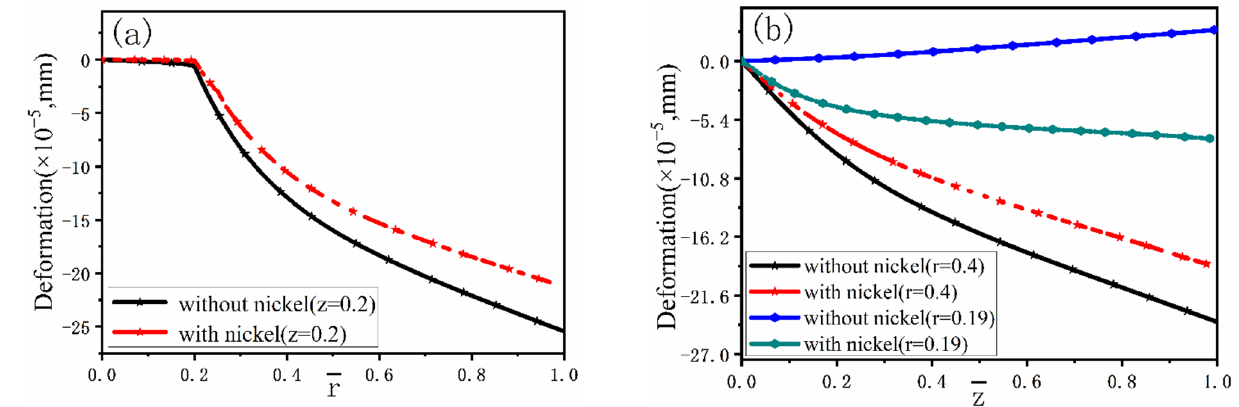
Figure 12. Deformation with and without nickel coating: ( a ) at z(cid:3364) = 0.2, ( b ) at r̅ = 0.19 and r̅ =